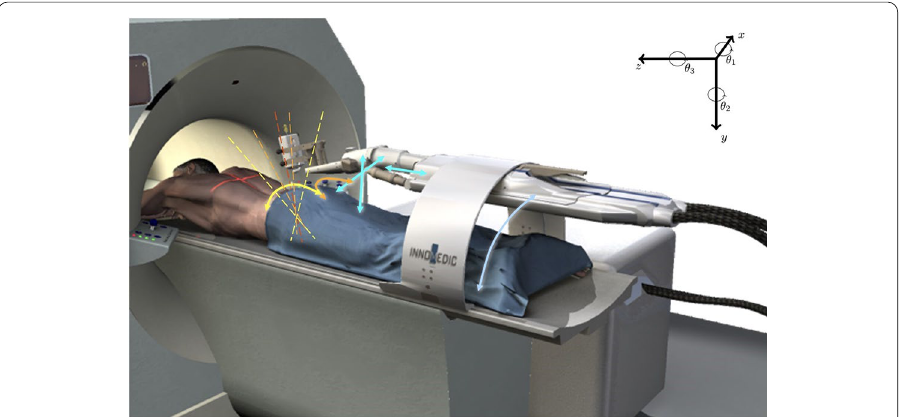
Fig. 1 Schematic representation of the InnoMotion robotic system. The possible directions of movement are indicated by the coloured arrows. Translational movements were performed along the z-axis and rotations around the x-axis ( θ 1 ). Innomedic GmbH [28]